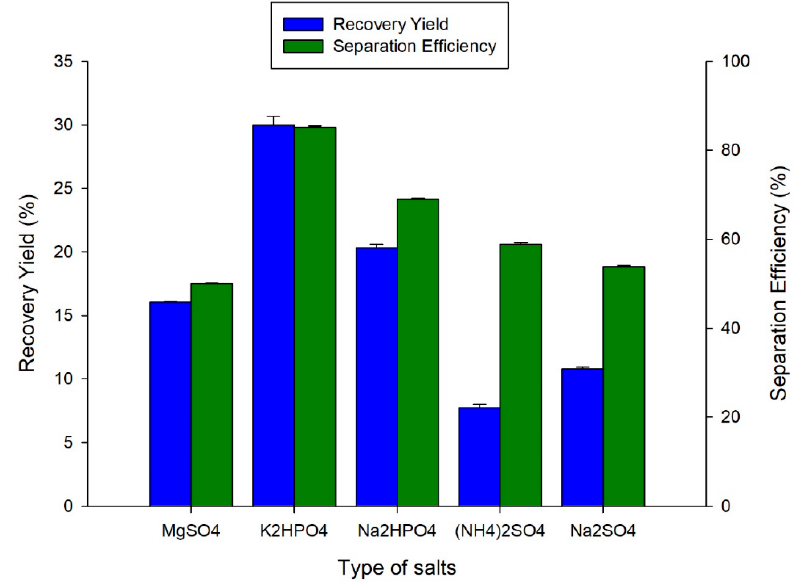
Figure 2. Figure showing the effect of different types of salts on the protein recovery yield and separation efficiency using LBF system.